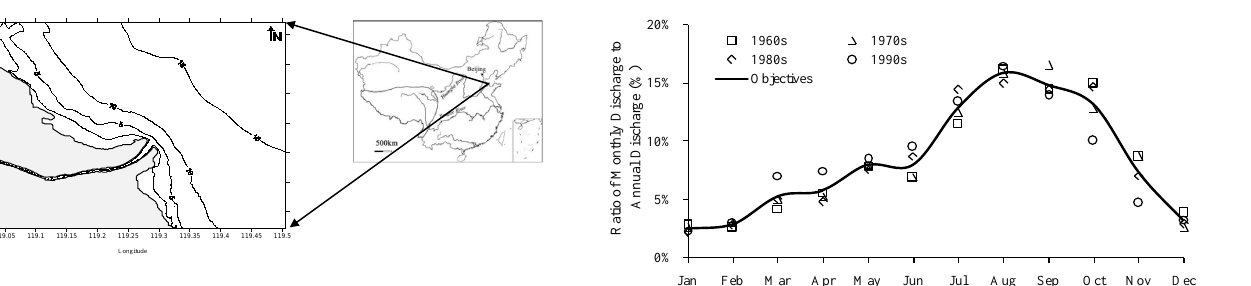
Fig. 1. Location of the Yellow River estuary.